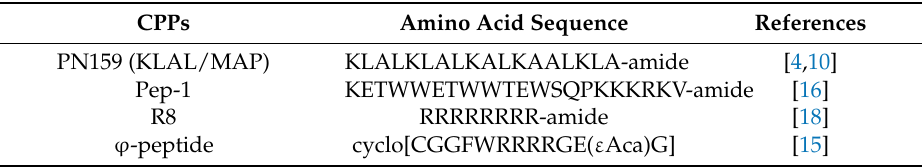
Table 1. The amino acid sequences of the tested cell-penetrating